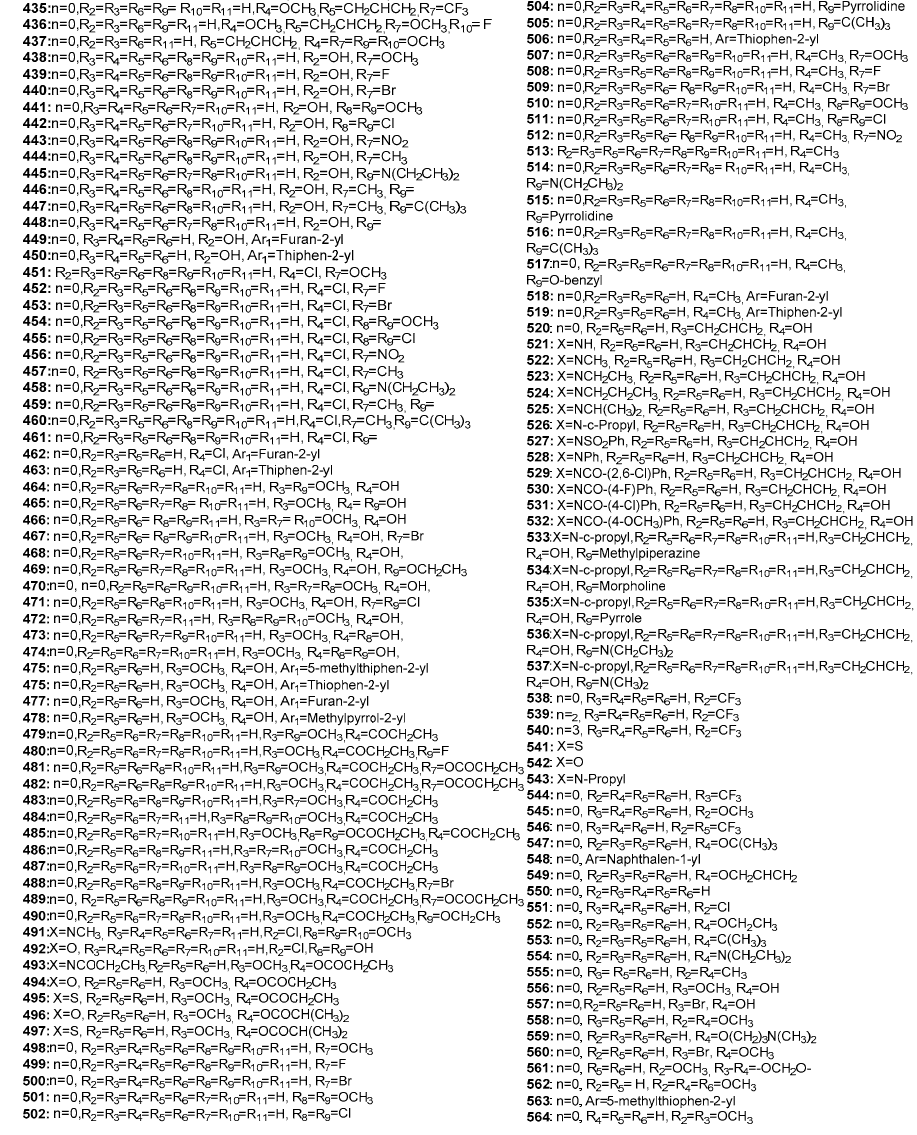
Figure 10. Diarylpentanoids with a promising inhibitory effect on pro-inflammatory cytokines. Another novel series of allylated or prenylated diarylpentanoids ( 405 – 437 : Figure 10) were designed, synthesized, and investigated against TNF- α and IL-6 expression induced by LPS using mouse RAW 264.7 macrophages. The majority of the tested compounds inhibited the LPS-induced expression of TNF- α and IL-6, particularly IL-6 expression, at a dosage of 10 µ M. Their inhibitory abilities were comparable to or more pronounced than curcumin ( 1 ) at the same concentration. It was seen that compounds 407 , 433 , 434 , and 437 exhibited stronger inhibition of both TNF- α and IL-6 than curcumin ( 1 ), with 433 being the most potent on LPS-induced TNF- α and IL-6 production with its inhibitory rates reaching 67.5% and 91.1%, respectively. Compound 433 also exhibited significant protection against LPS-induced death in septic mice. SAR studies suggested that the electronic properties of the substituents on the aromatic rings seem to have no influence on bioactivity, and the di- or tri-substituted compounds are much more active than mono-substituted compounds (Figure 11)